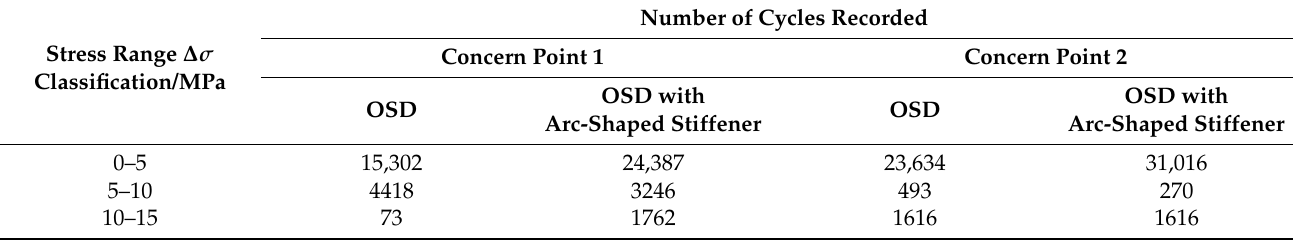
Table 5. Stress range and corresponding cycles of concern